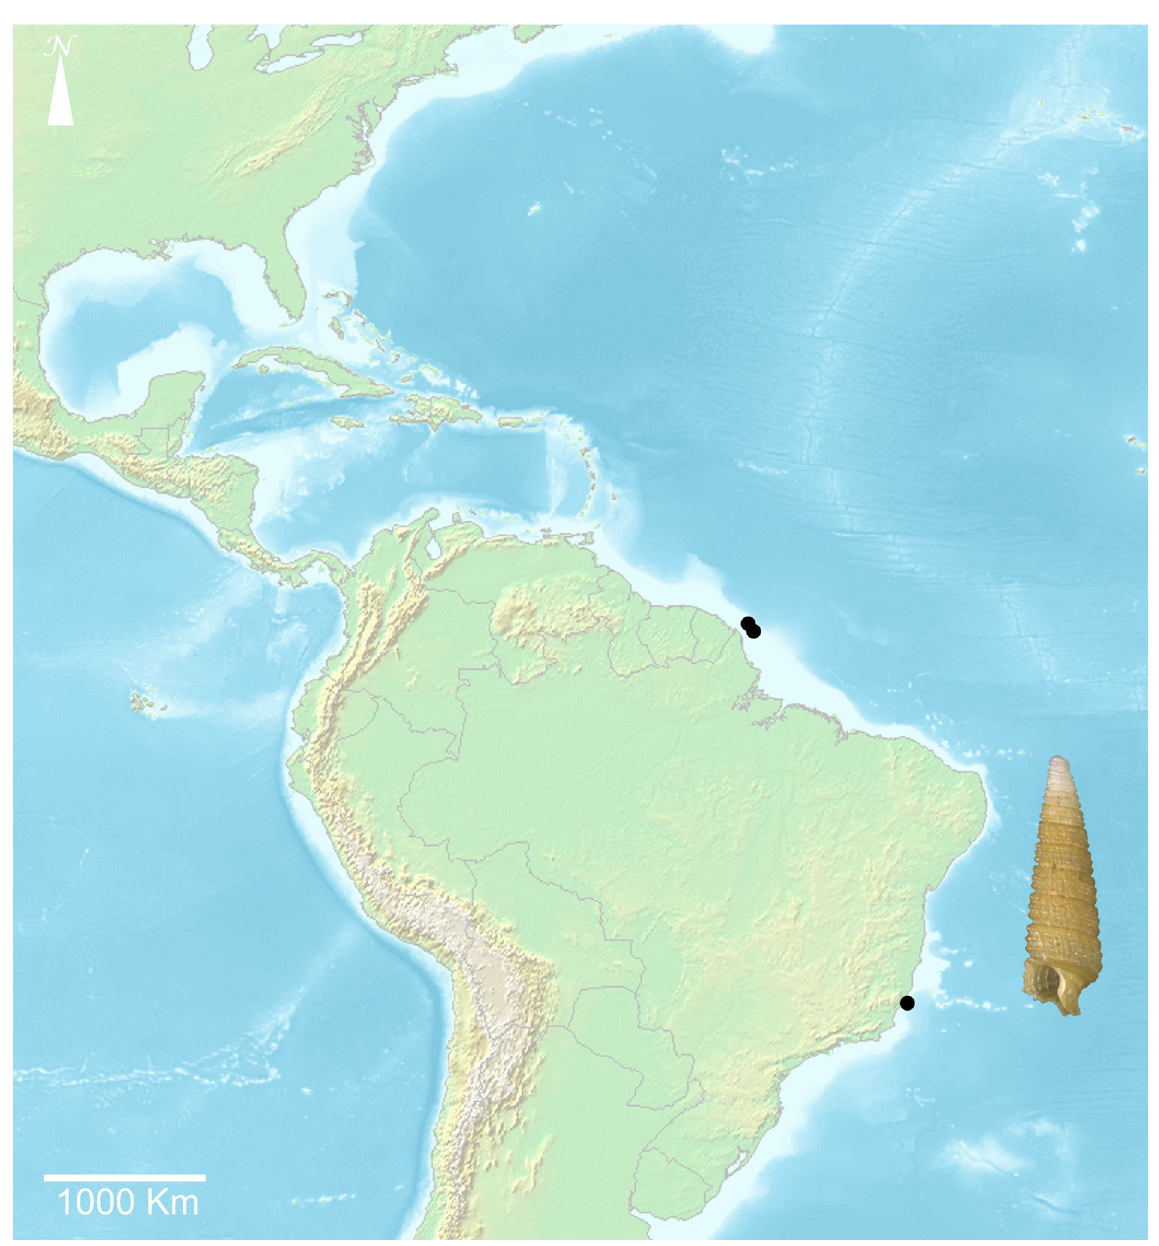
Fig. 47. Distribution map of “ Inella ”